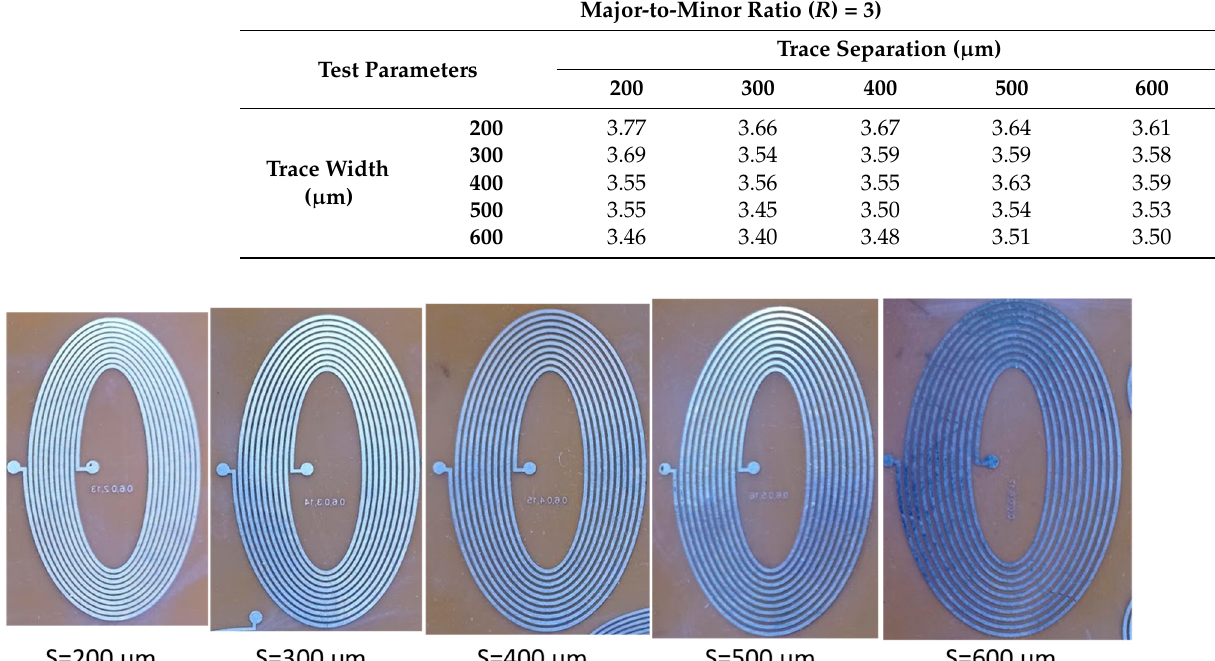
Figure 7. Elliptical planar inductors with a width of 600 μ m and varying separation ( S ) while major-to-minor ratio ( R ) = 3 and number of turns ( N ) = 10 were kept constant.